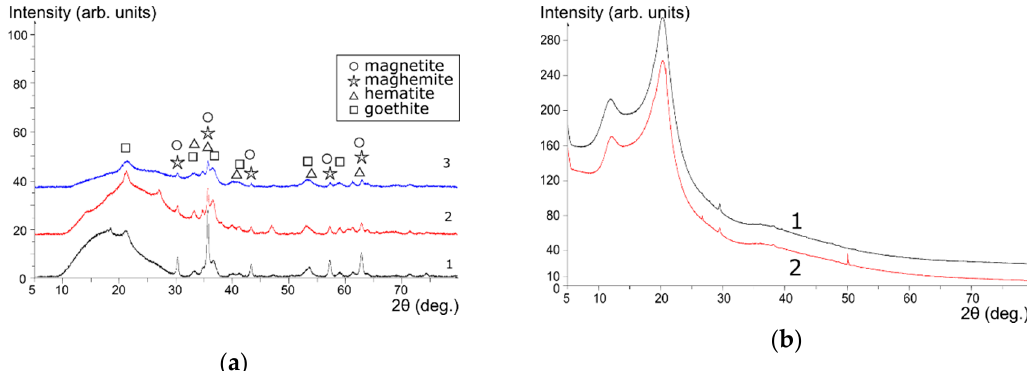
Figure 1. Scanning electron microscopy–energy dispersive X-ray spectroscopy (SEM–EDX) analysis of composite sorbents. Sorbents ( a ) 1A; ( b ) 2M; and ( c ) 3M.